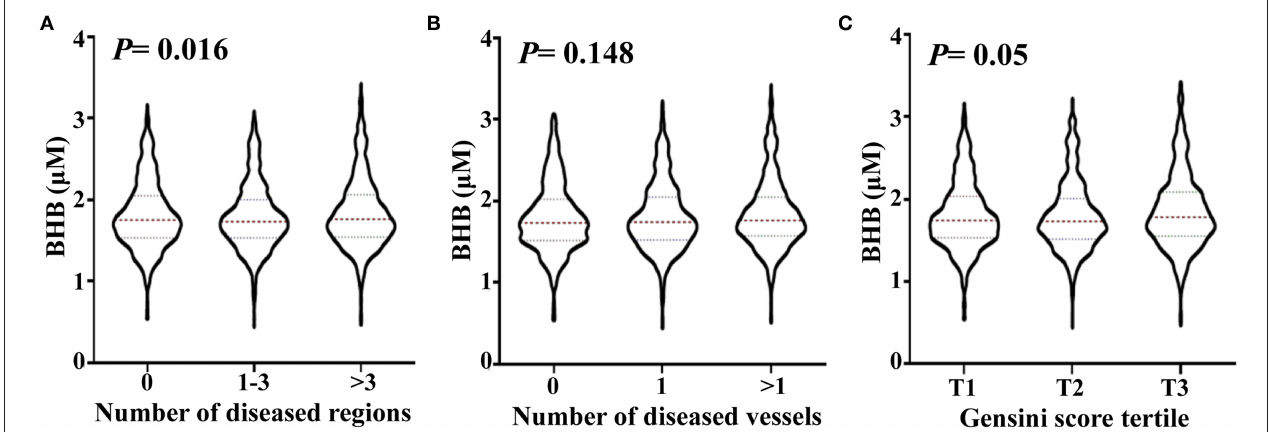
FIGURE 1 | Association of the serum BHB level with the severity of coronary artery lesion. Violin plots of serum BHB concentrations at presentation with the number of stenosed regions (A) , the number of stenosed vessels (B) and tertile of the Gensini scores (C) , showing median (red dashed line) and interquartile ranges (blue dashed line) on a log 10 scale. p < 0.05 considered statistically significant.